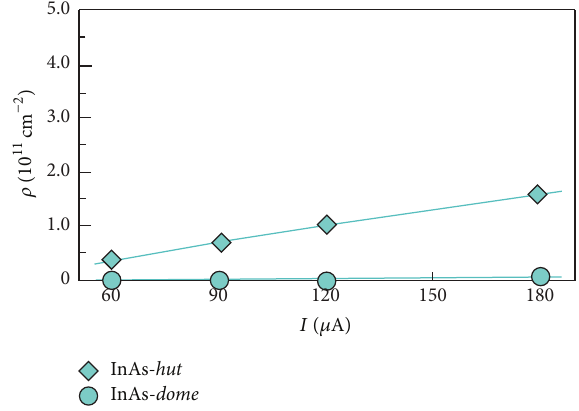
Figure 6: Temperature dependence of InAs nanoislands average size.